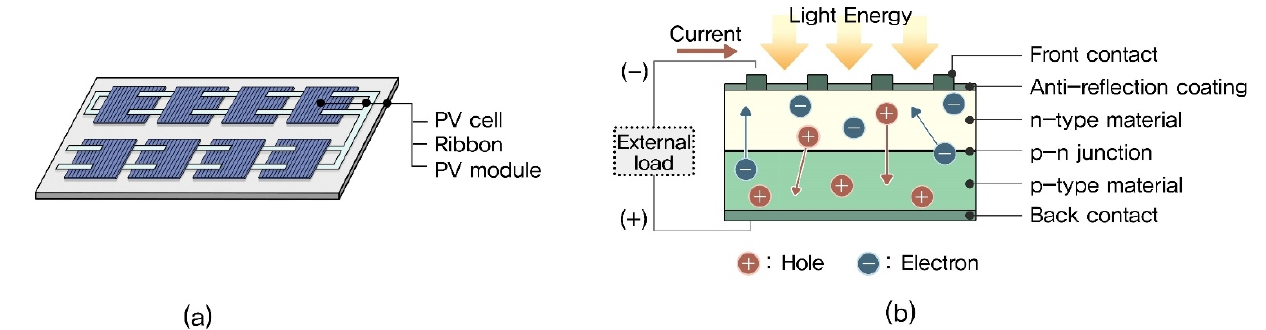
Figure 2. Photovoltaic module concept and power generation principle of photovoltaic cells: ( a ) Photovoltaic module concept, ( b ) Principle of the power generation.